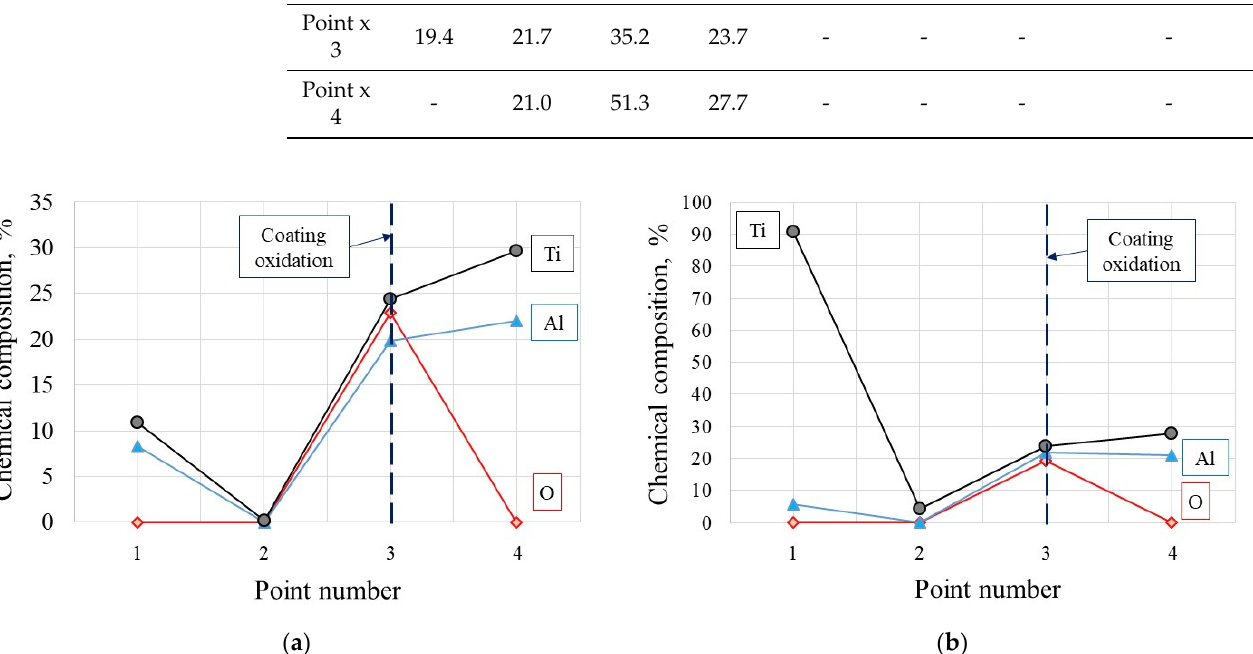
Figure 12. Average semi-quantitative chemical composition detected in points 1, 2 and 3 at the rake faces in Figures 8a and 9a after machining of IN718 ( a ) and Ti6-4 ( b ) alloys with the cutting speed of 200 m/min; machining time of 30 s (data specified in Table 6, respectively).